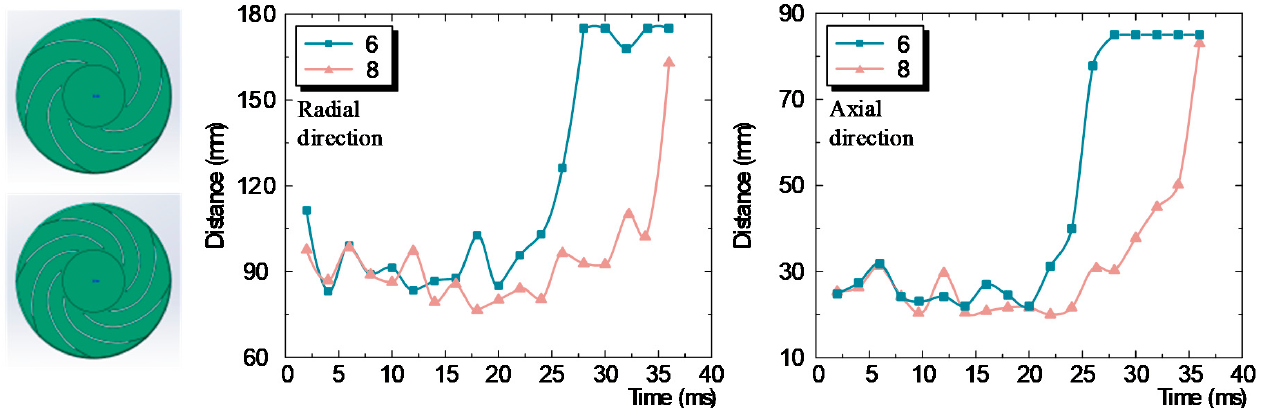
Figure 14. A comparison of arc diffusion under different electrode structure design with different numbers of the spiral-shaped